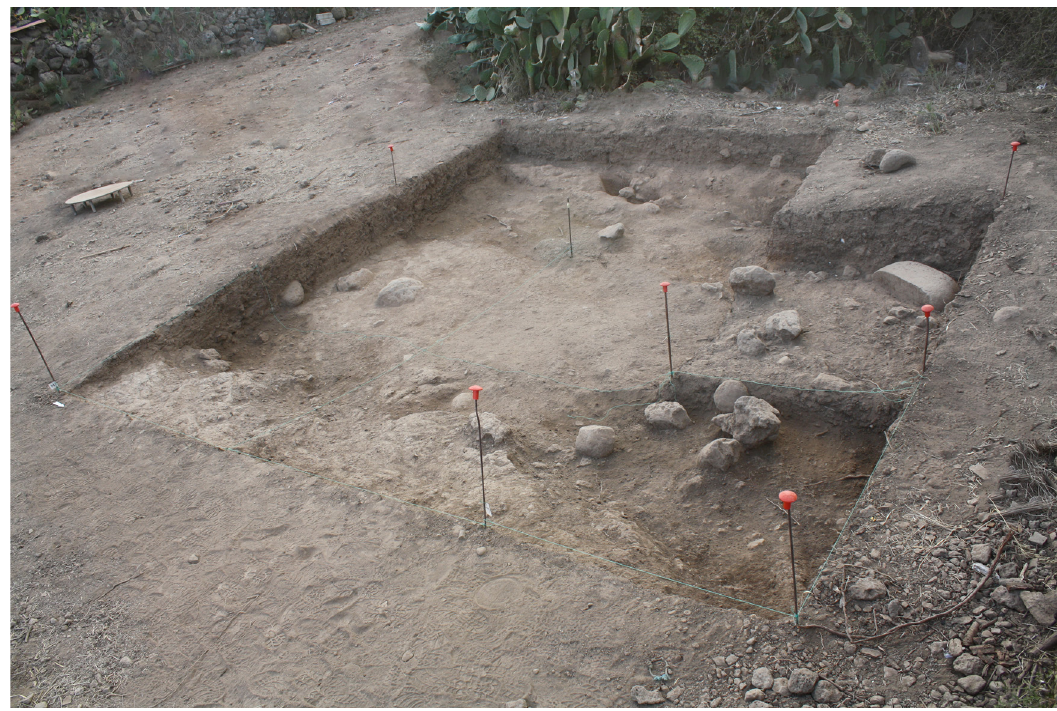
Figure 6: Area 2, view from North -